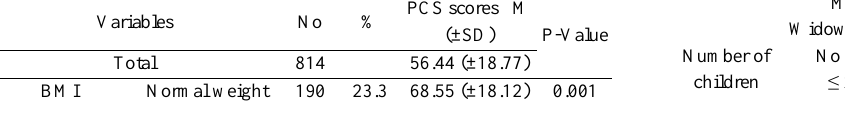
Table 1: The Physical Component Summary score of Health- related quality of life, Mean (±SD) scores according to variables classification of the study sample.